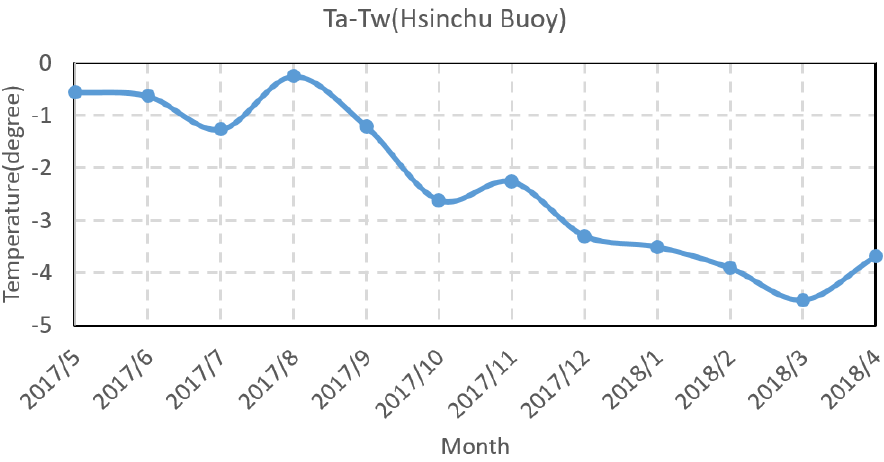
Figure 12. Temperature difference between the air and the sea surface.